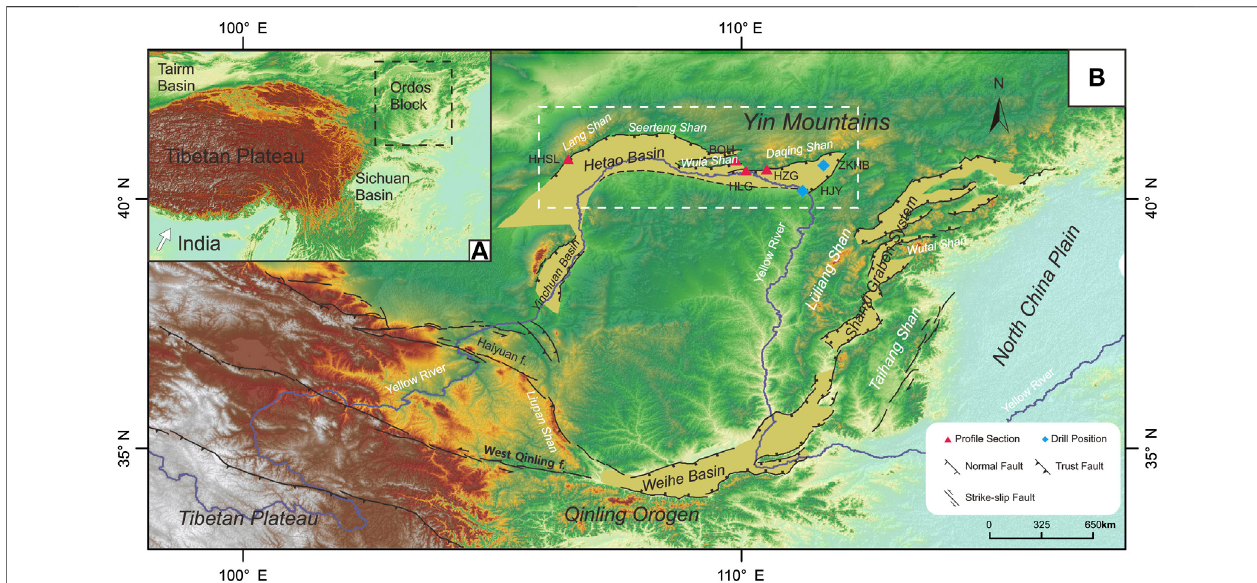
FIGURE 1 | (A) Location and topography of the graben systems around the Ordos Block adjacent to the northeast margin of the Tibetan Plateau (B) Tectonic pattern of the Ordos Block and its adjacent regions (modi fi ed from Deng et al., 2002). The dashed box denotes the study area. Yellow areas represent the rifted basins surroundingtheOrdosBlock,includingtheYichuan-JilantaiandHetaoBasinstothewestandnorth,ShanxiGrabentotheeast,andWeiheBasintothesouth.DEMdata originated from https://earthdata.nasa.gov/.